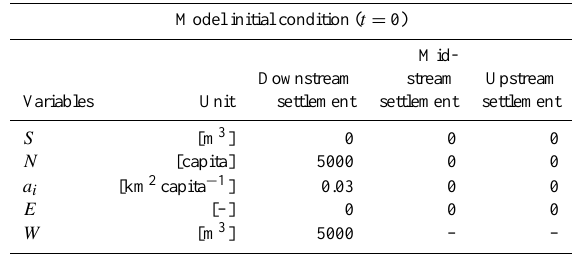
Table 1. Model initial condition